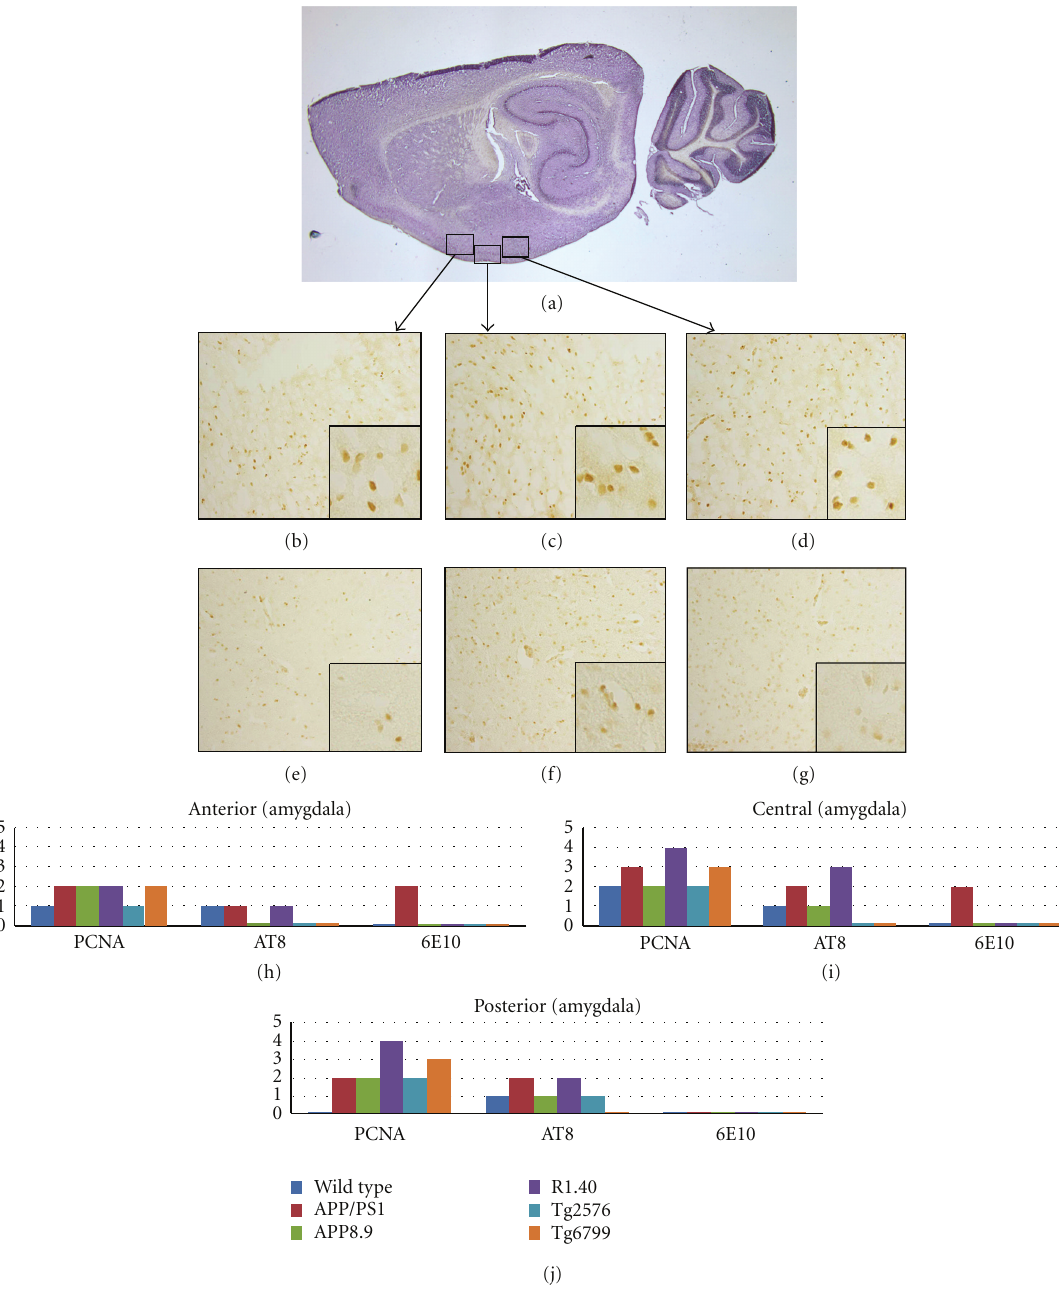
Figure 3: Comparison among the mouse lines studied with respect to the presence of cell cycle events (PCNA), tau-phosphorylation (AT8), and beta-amyloid plaque deposition (6E10) in the amygdala. (a) Sagittal section of a wild-type mouse brain indicating the approximate location of the amygdala. The three black boxes indicate the regions identified as anterior (left), middle (center) and posterior (right). (b)– (g) Representative fields illustrating the involvement of cell cycle processes in the three regions. The insets are representative fields shown at higher magnification to illustrate the qualities of the cell cycle staining. Anterior amygdala for R1.40 (b) and wild-type (e) mice contains the lowest density of CCEs. Middle regions of the amygdala in R1.40 (c) and wild-type (f) mice show increased staining in most models. Posterior amygdala in R1.40 (d) but not wild type (g) animals also show cell cycle activity. (h) Quantification of the extent of immunostaining for the cell cycle, phospho-tau, and beta-amyloid plaques in the five transgenic models plus wild